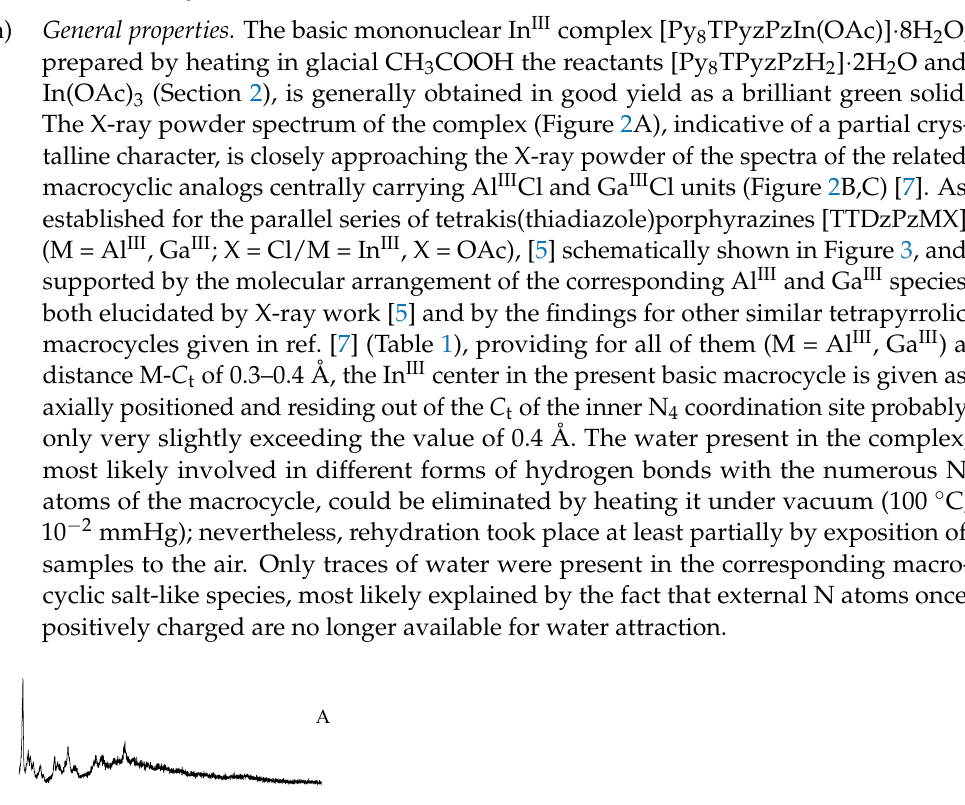
Figure 3. Schematic view of the complexes [TTDPzMX] (M = Al III , Ga III ; X = Cl; M = In III , X = OAc) [5]. Table 1. UV-visible spectral data ( λ , nm (log ε )) of [Py 8 TPyzPzIn(OAc)], [(2- Mepy) 8 TPyzPzIn(OAc)](I) 8 ,